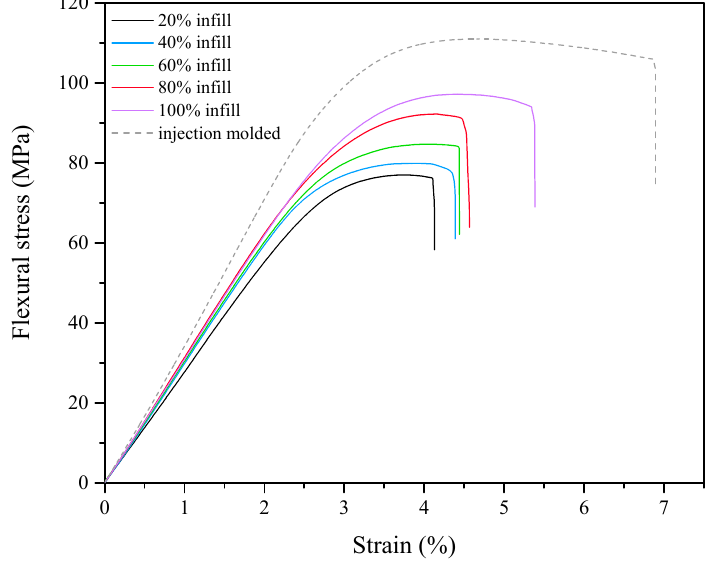
Figure 4. A stress-strain diagram for the three-point bending test. Table 2. Flexural properties of 3D-printed/injection moulded PLA specimens.